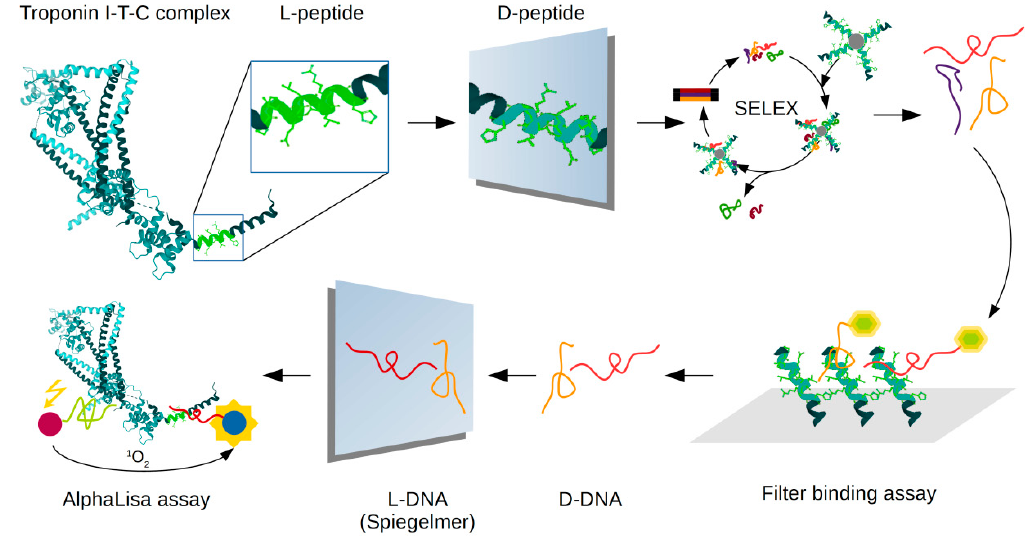
Figure 1. Schematics of spiegelmer-based sandwich assay development for cardiac troponin I detection. These proof of concept results provide the first example for fully spiegelmer-based sandwich assay of diagnostic potential as supported by their applicability for cTnI in blood plasma.